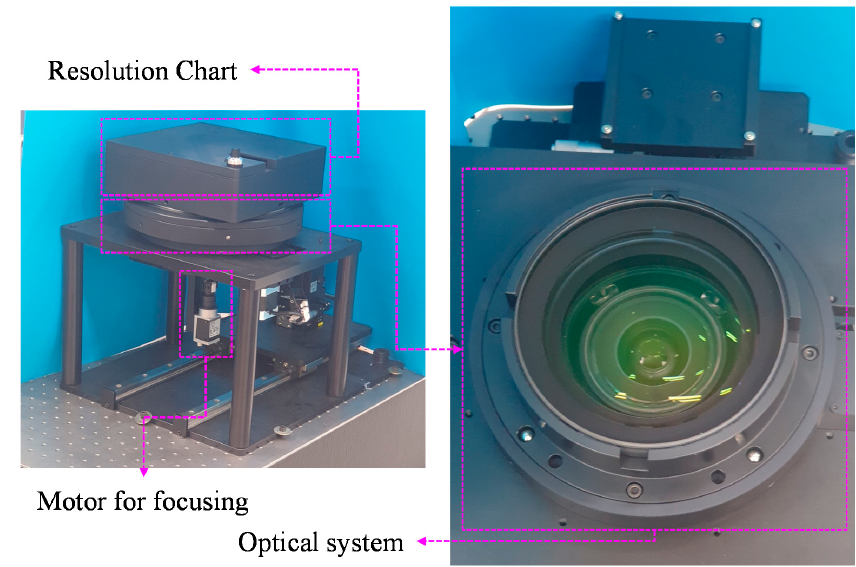
Figure 9. Manufacturing result of the optical system shown in Figure 5.